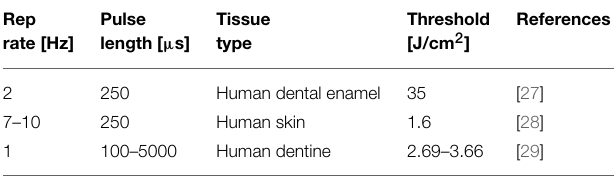
TABLE 1 | Fluences for ablation thresholds for different tissue